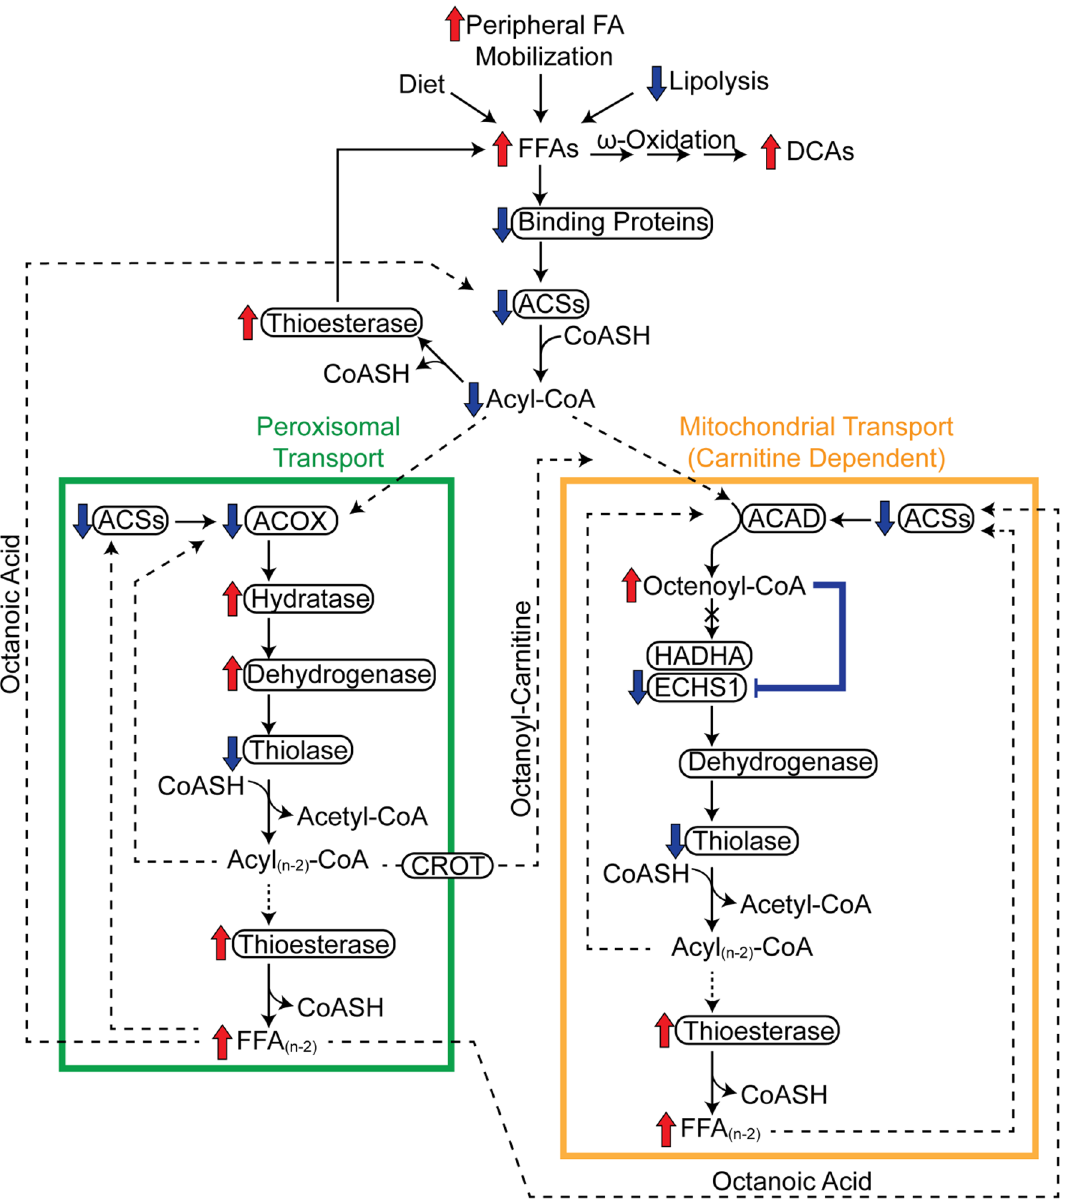
Figure 9. Summary of the effects of TCDD on fatty acid oxidation. Inhibition of β-oxidation in TCDD-induced hepatic steatosis involves the (i) repression of FA binding proteins, (ii) repression of FA activation, and (iii) induction of thioesterase activity. Acyl-CoA synthetase repression reduces activated FAs available for β-oxidation while the repression of binding proteins increases acyl-CoA susceptibility to hydrolysis by induced thioesterases. VLCFAs and LCFAs were partially metabolized in peroxisomal β-oxidation (green box) to medium-length chain FAs (MCFAs) due to peroxisomal specific thioesterase activity which deactivates acyl-CoAs. Peroxisomal CROT transports MCFAs out of peroxisomes to the mitochondria (orange box). MCFAs, such as octanoic acid, could also diffuse out of peroxisomes and into mitochondria where they undergo oxidation following activation by acyl-CoA synthetases. In the canonical pathway, acyl-CoAs are first oxidized by acyl-CoA dehydrogenases that were minimally affected by TCDD. Two enzymes catalyze the subsequent step of mitochondrial β-oxidation; HADHA (which prefers long chain acyl-CoAs) and ECHS1 which prefers short and medium chain acyl-CoAs. Peroxisomal and mitochondrial medium chain acyl- CoA species would accumulate, specifically octenoyl-CoA, due to substrate overload and inhibition of ECHS1 activity by accumulating octenoyl-CoA levels. Octenoyl-CoA accumulation also sequesters free CoASH inhibiting other CoASH-dependent reactions including the thiolytic cleavage of the ketoacyl-CoA into acetyl-CoA and an acyl-CoA that is 2 carbons shorter. Therefore, TCDD dose-dependently induced a futile cycle of FA activation and acyl-CoA hydrolysis leading to octenoyl-CoA accumulation that inhibits ECHS1 activity and depletes free coenzyme A required by enzymes in other pathways leading to the inhibition of β-oxidation and energy depletion. With β-oxidation impaired, accumulating FFAs undergo ω-oxidation leading to increases in DCAs. Proteins are denoted with an oval. Red arrows indicate induction and blue arrows indicate repression. Solid lines denote reactions while dashed lines denote substrate trafficking. The figure was created using Adobe Illustrator